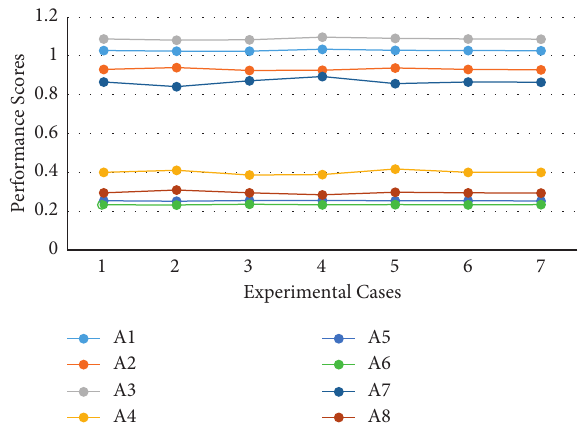
Figure 4: Variations in the performance scores during sensitivity